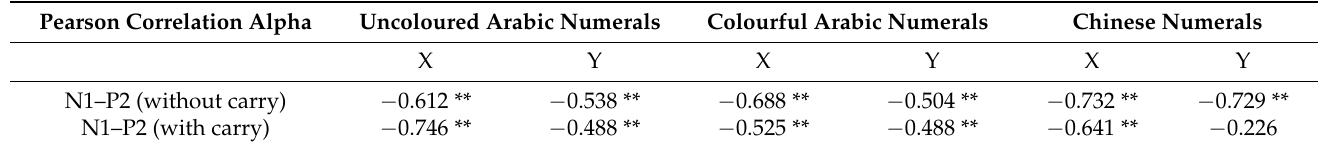
Table 3. Correlations between N1 mean amplitudes and P2 mean amplitudes elicited by the numbers X and Y resulting from different difficulty levels (without carryover or with carryover) for different material categories (uncoloured Arabic numerals, colourful Arabic numerals, and Chinese numerals). It is worth noting that for numerical direction adjustment conversion, the values of the N1 component were multiplied by a negative